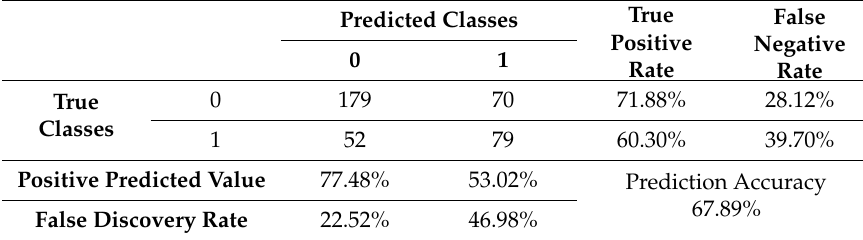
Table 2. Confusion matrix of the model without the SVO